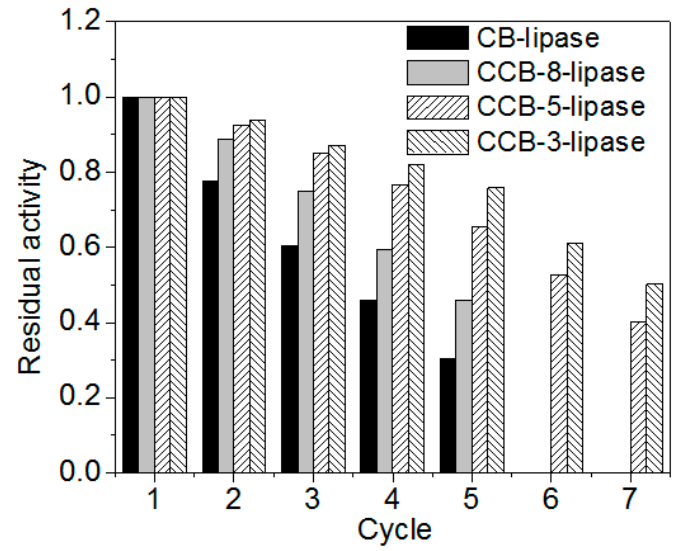
Figure 7. Reusability of immobilized lipases. Catalysts 2017 , 7 , 302